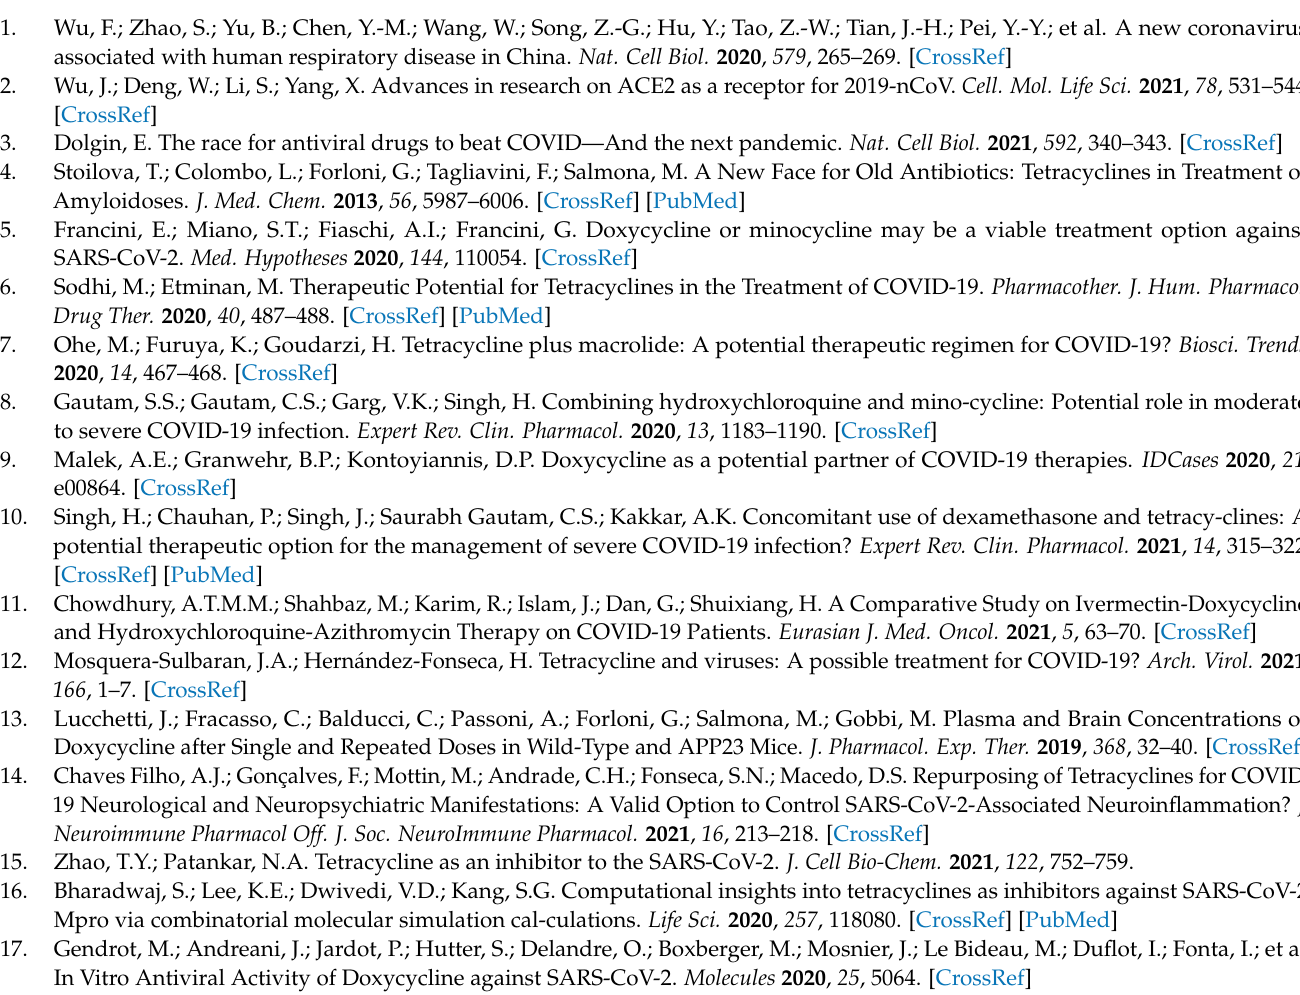
Figure S2: Dose-response effect of gentamicin in VeroE6 cells; Figure S3: Binding of doxycycline to BSA; Figure S4: Doxycycline did not affect cell viability and proliferation; Figure S5: Effect of doxycycline on ACE2 expression; Figure S6: Surface plasmon resonance shows no direct binding of doxycycline to S, S1, RBD and ACE2